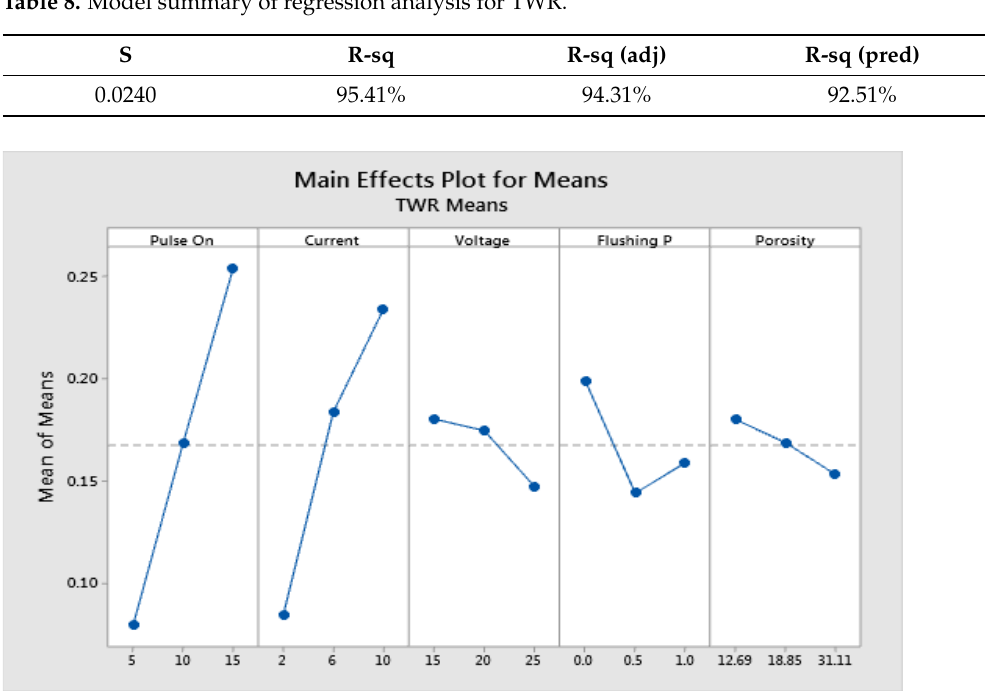
Table 8. Model summary of regression analysis for TWR.